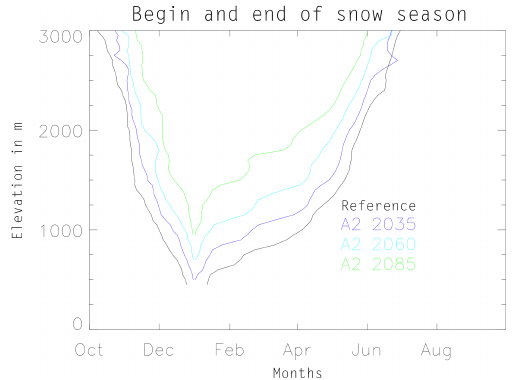
Figure 7. Begin and end of a continuous snow cover for the A2 emission scenarios for the reference and three future time periods in the Aare